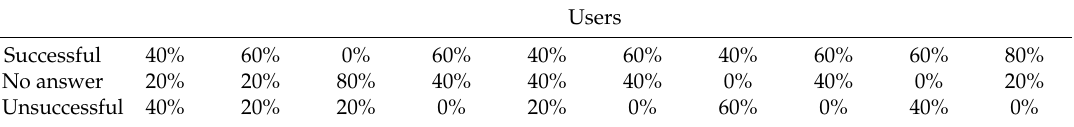
Table 7. Successful answer, no answer and unsuccessful answer ratios in skeuomorphic design.